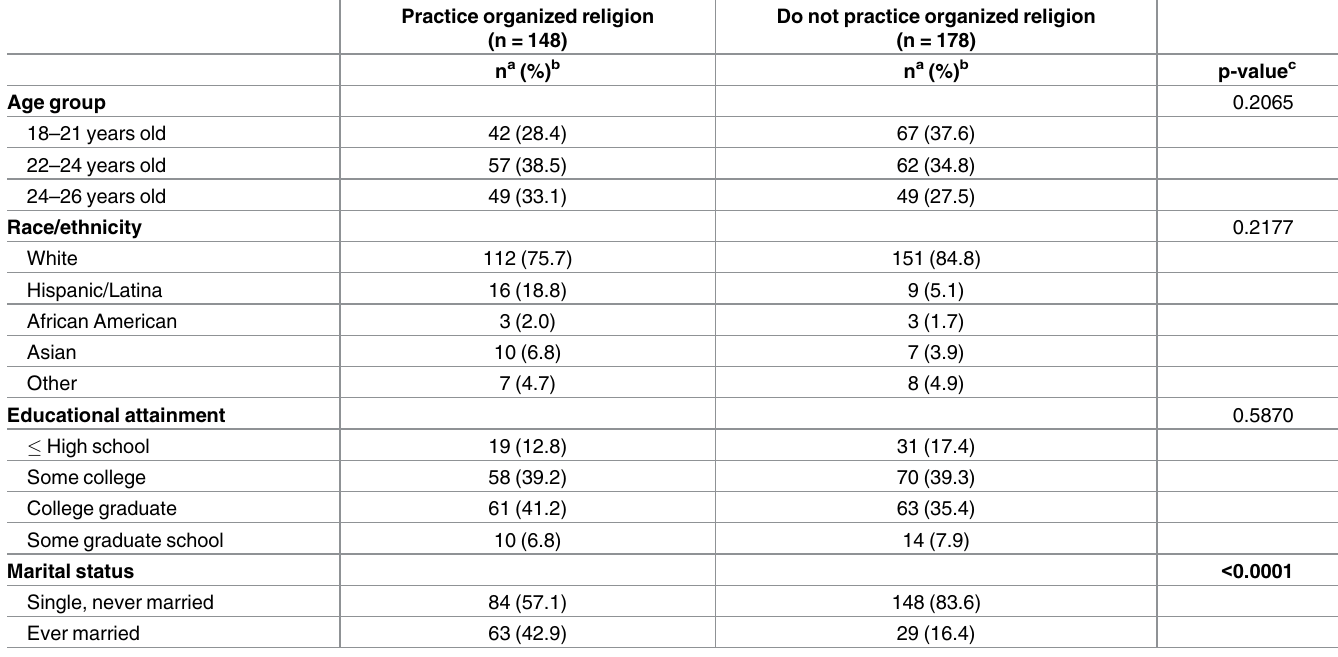
Table 1. Demographic characteristics of participants by religious practice (N =